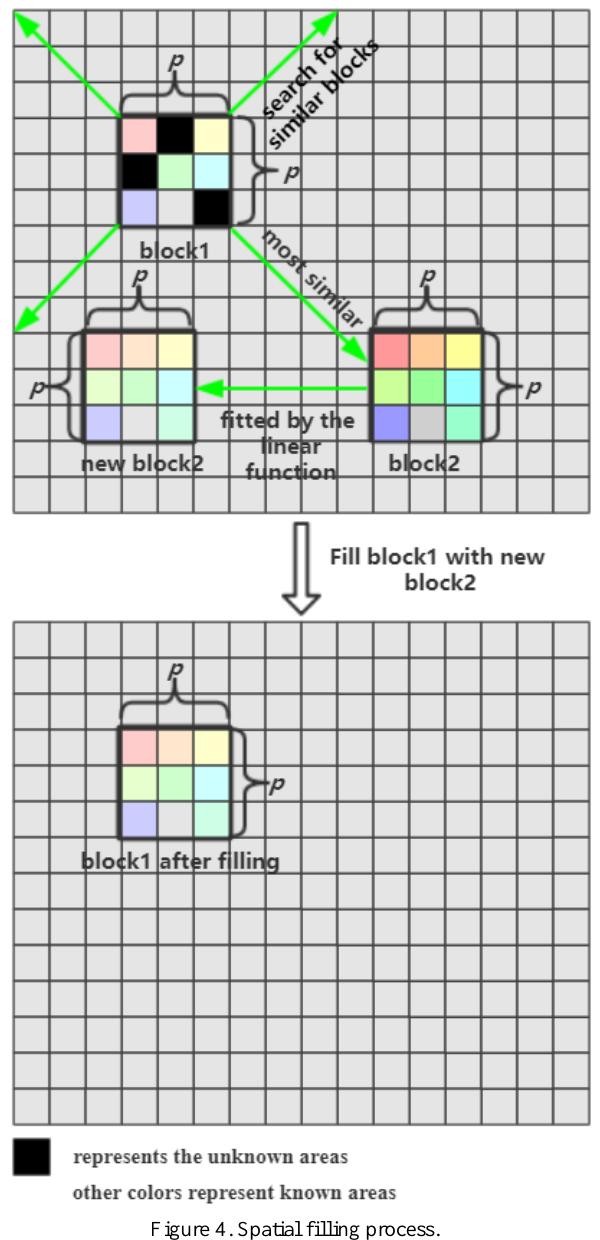
Figure 4. Spatial filling process.